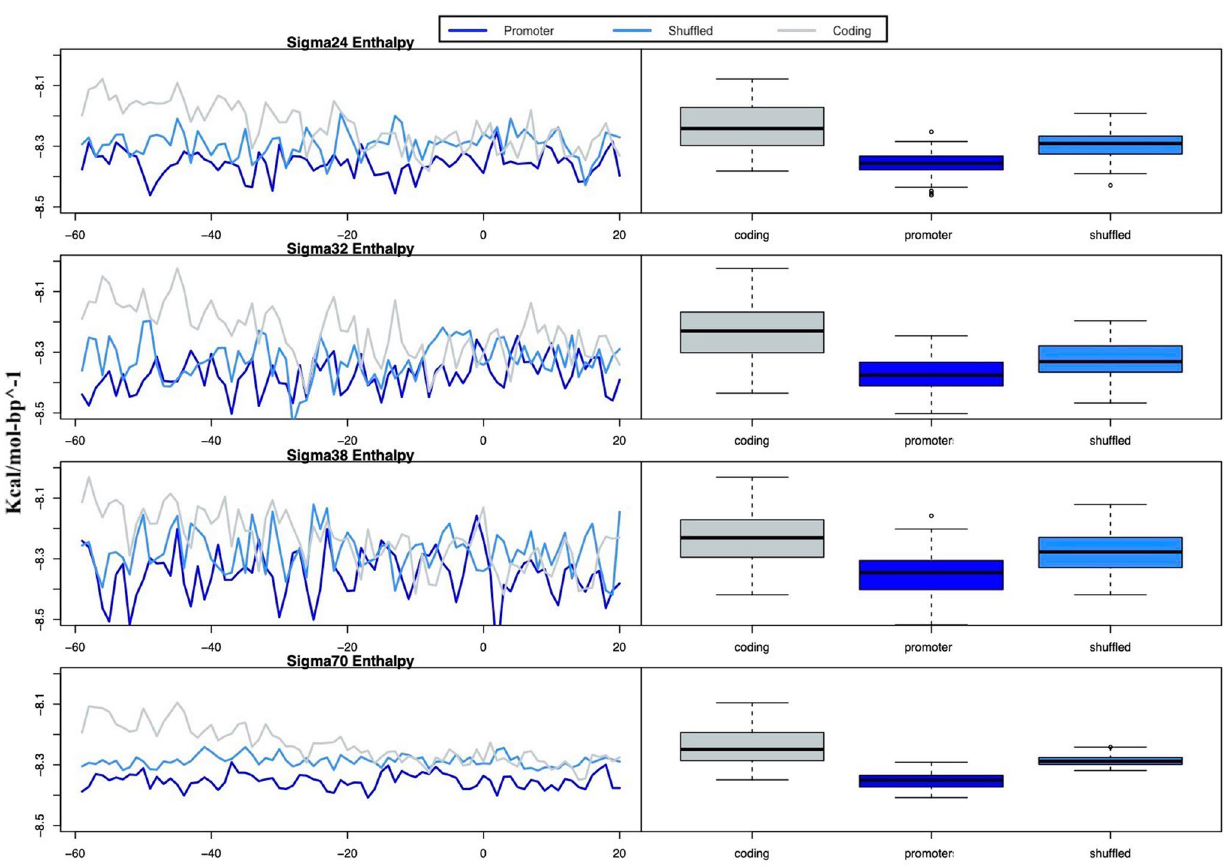
panel represents the boxplots of the profiles of promoter, shuffled, and coding sequences, whose Y-axis is in the same scale as the left